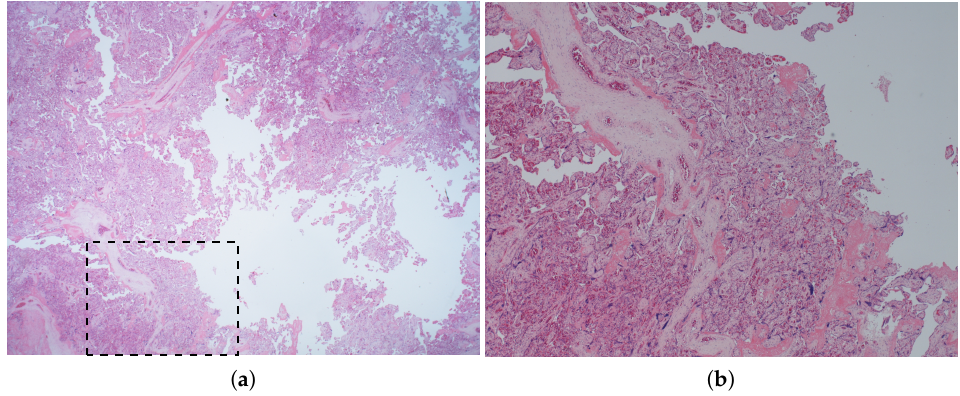
Figure 14. ×12 ( a ) and ×40 ( b ) magnification photomicrographs of a representative histological section of placenta after needle insertion and exposure to light from a bare fibre, demonstrating physical villus separation at the needle track but no heat-related tissue damage. The zoomed section shown in ( b ) is indicated by the dashed rectangle in ( a